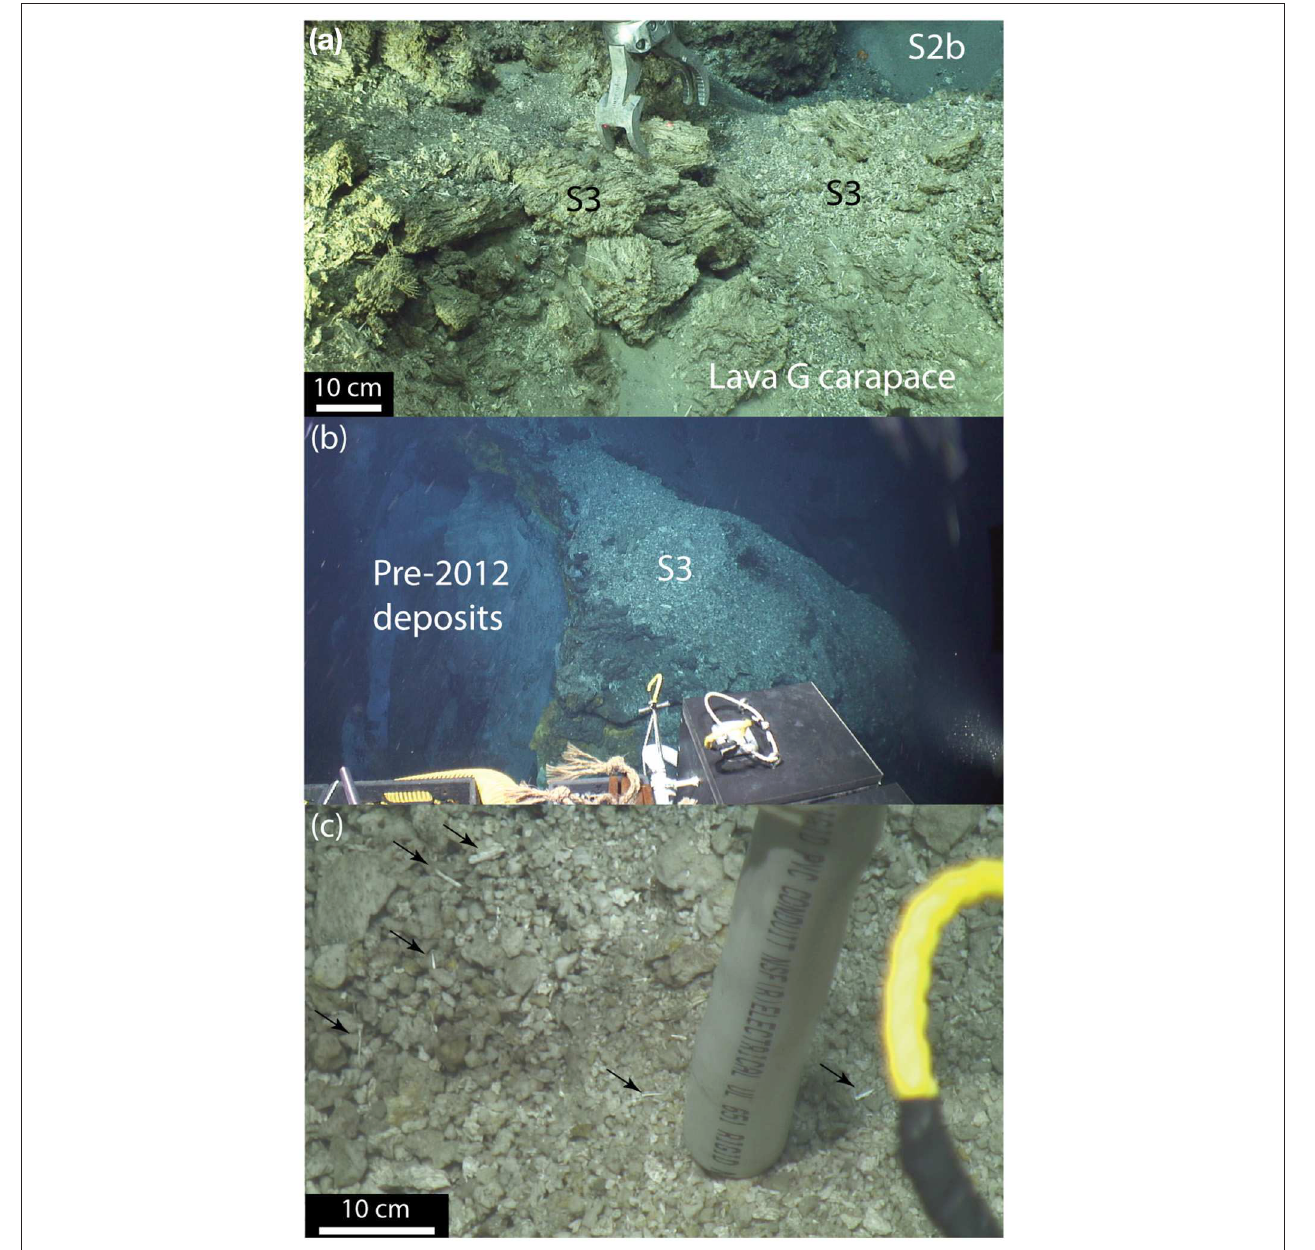
FIGURE 2 | (a) Subunit 3 overlies the Lava G carapace and is overlain by Subunit 2b deposits. Decimeter scale blocks are the largest grains of S3, and sit on top of Lava G. (b) Subunit 3 at sampling site HVR070 has no overlying deposits and is underlain by pre-2012 deposits (c) Sample location HVR033, on top of Lava G where dome sample HVR031 was taken ( Figure 1 ). Elongate tube-vesicle particles can be seen in this talus slope, demonstrating that S3 deposits overlie this pre-2012 lava dome, ∼ 47m higher than Lava